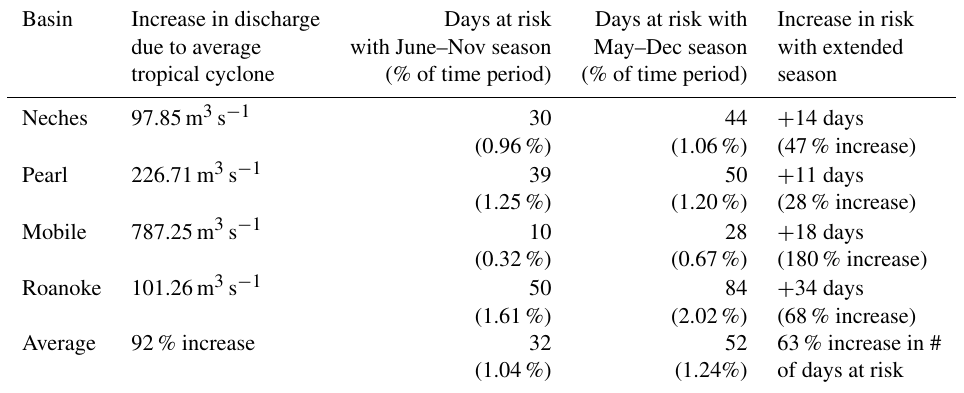
Table 2. Flooding risk from 1998 to 2014 for the four study basins with the current hurricane season and with an extended May–December hurricane